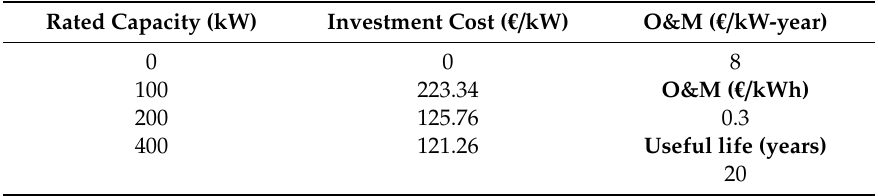
Table A3. Diesel units